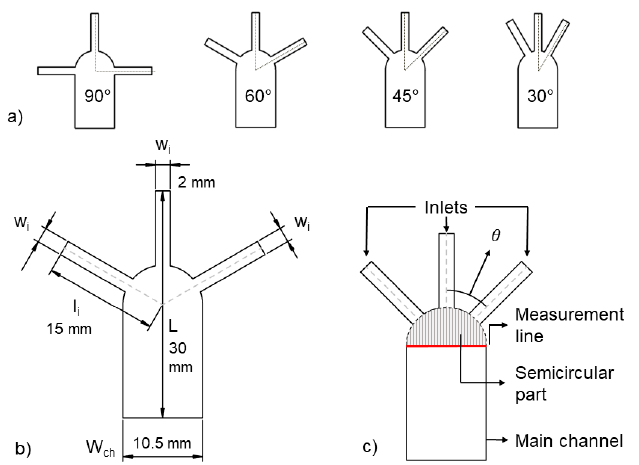
Figure 2. Schematics of the substrate geometry. ( a ) from left to right: Substrate geometries of the 90, 60, 45 and 30-degree models. Channel width (W ch ), paper strip length (L), inlets branch width (w i ) and measurement line are also displayed in ( b , c ).